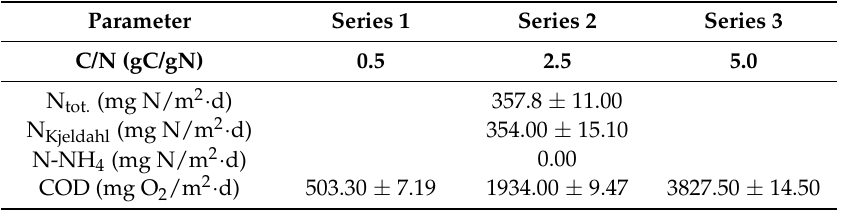
Table 2. The average ( ± SD) reactor pollutant